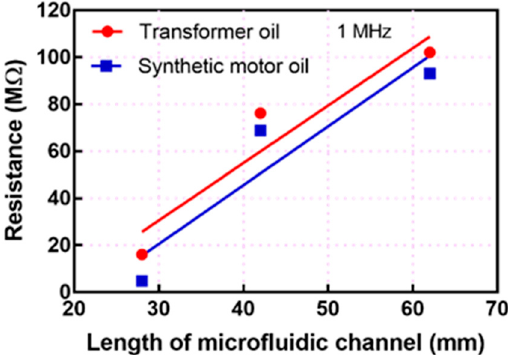
Figure 10. Resistance as a function of the microfluidic channel length, for transformer oil and synthetic motor oil as resistive liquid materials inside the channel.